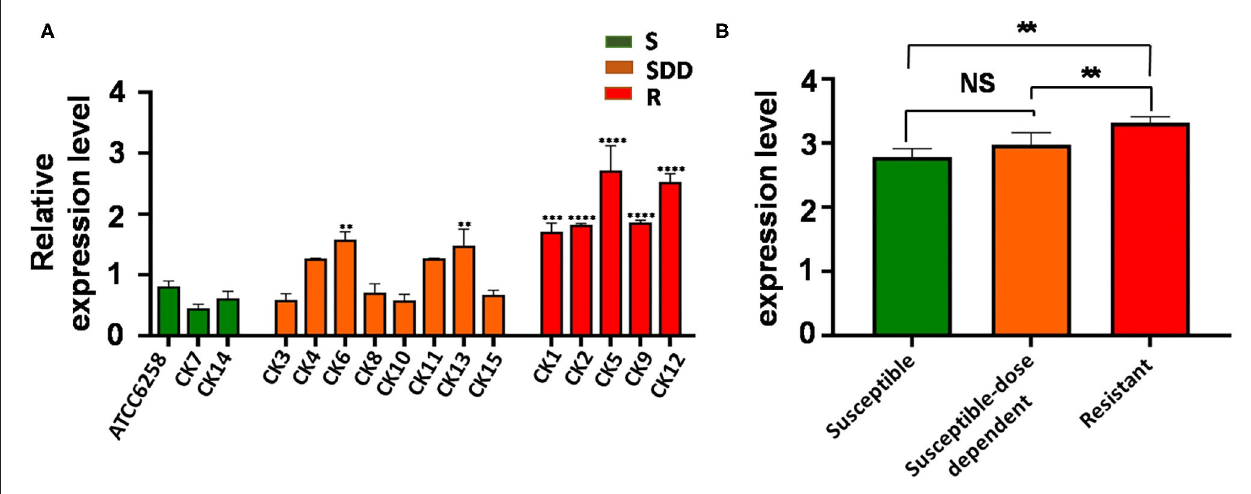
FIGURE 1 | ERG11 relative gene expression levels in three groups of C. krusei clinical isolates. (A) Relative levels of ERG11 mRNA in all the C. krusei clinical isolates. ERG11 gene expression levels were quantified and normalized relative to the reference gene, GAPDH; S, itraconazole-susceptible; SDD, itraconazole-susceptible dose dependent; R, itraconazole-resistant. Asterisks indicate that the difference between field isolates with the reference strain ATCC 6258 is significant compared to the reference strain ATCC 6258: ** p < 0.01 in CK6, CK13 with ATCC6258; *** p < 0.001 in CK1 with ATCC6258; and **** p < 0.0001 in CK2, CK5, CK9, CK12 with ATCC6258. (B) Log10 + 3 fold increase of gene expression levels in three groups (NS, no significance in SDD compared with S; * p < 0.05 in R with SDD; ** p < 0.01 in R with